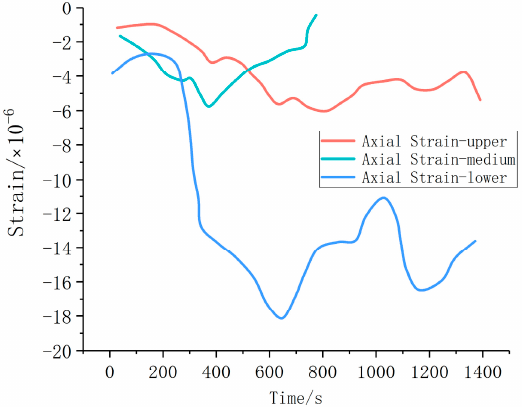
Figure 9. Lateral strain–time curve of press cell under stress.